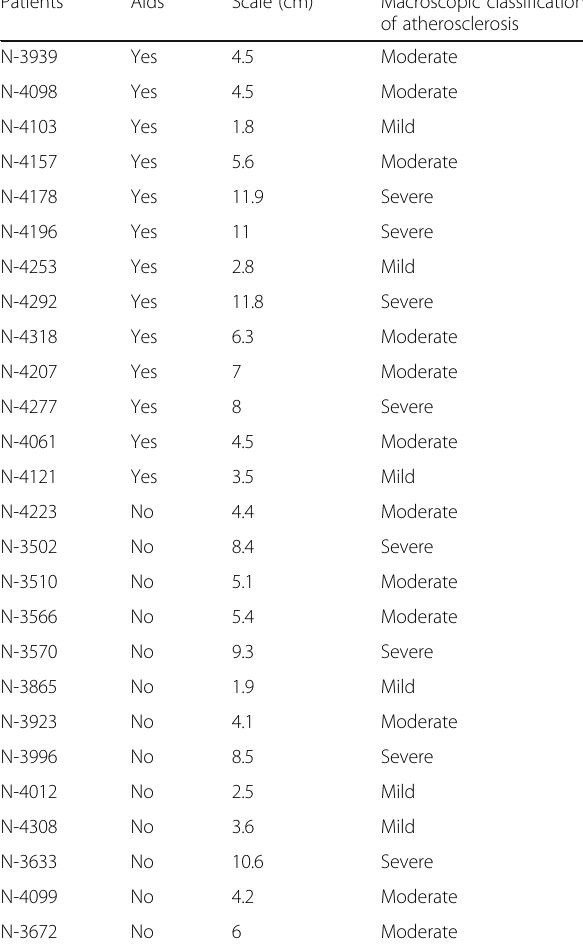
Table 4 Centimeters of atherosclerosis in aorta patients in each group Patients